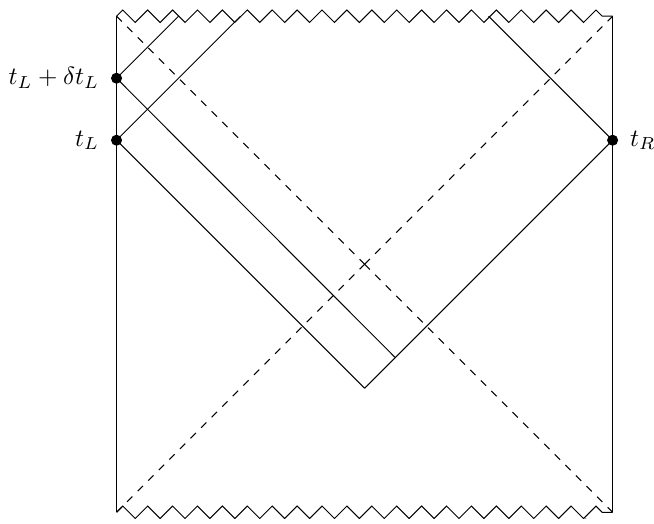
Figure 4. Two WdW patches in an AdS-Schwarzschild spacetime. As we evolve the boundary time t L , the WdW patch moves upwards, which determines the time dependence of